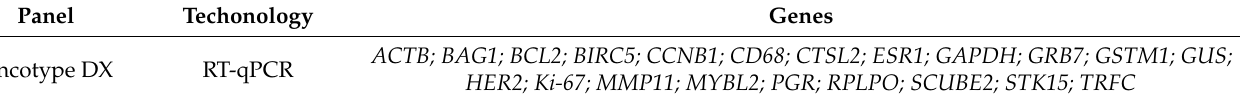
Table 3. Commercial panels for prognostic evaluation of BC patients using mRNA gene